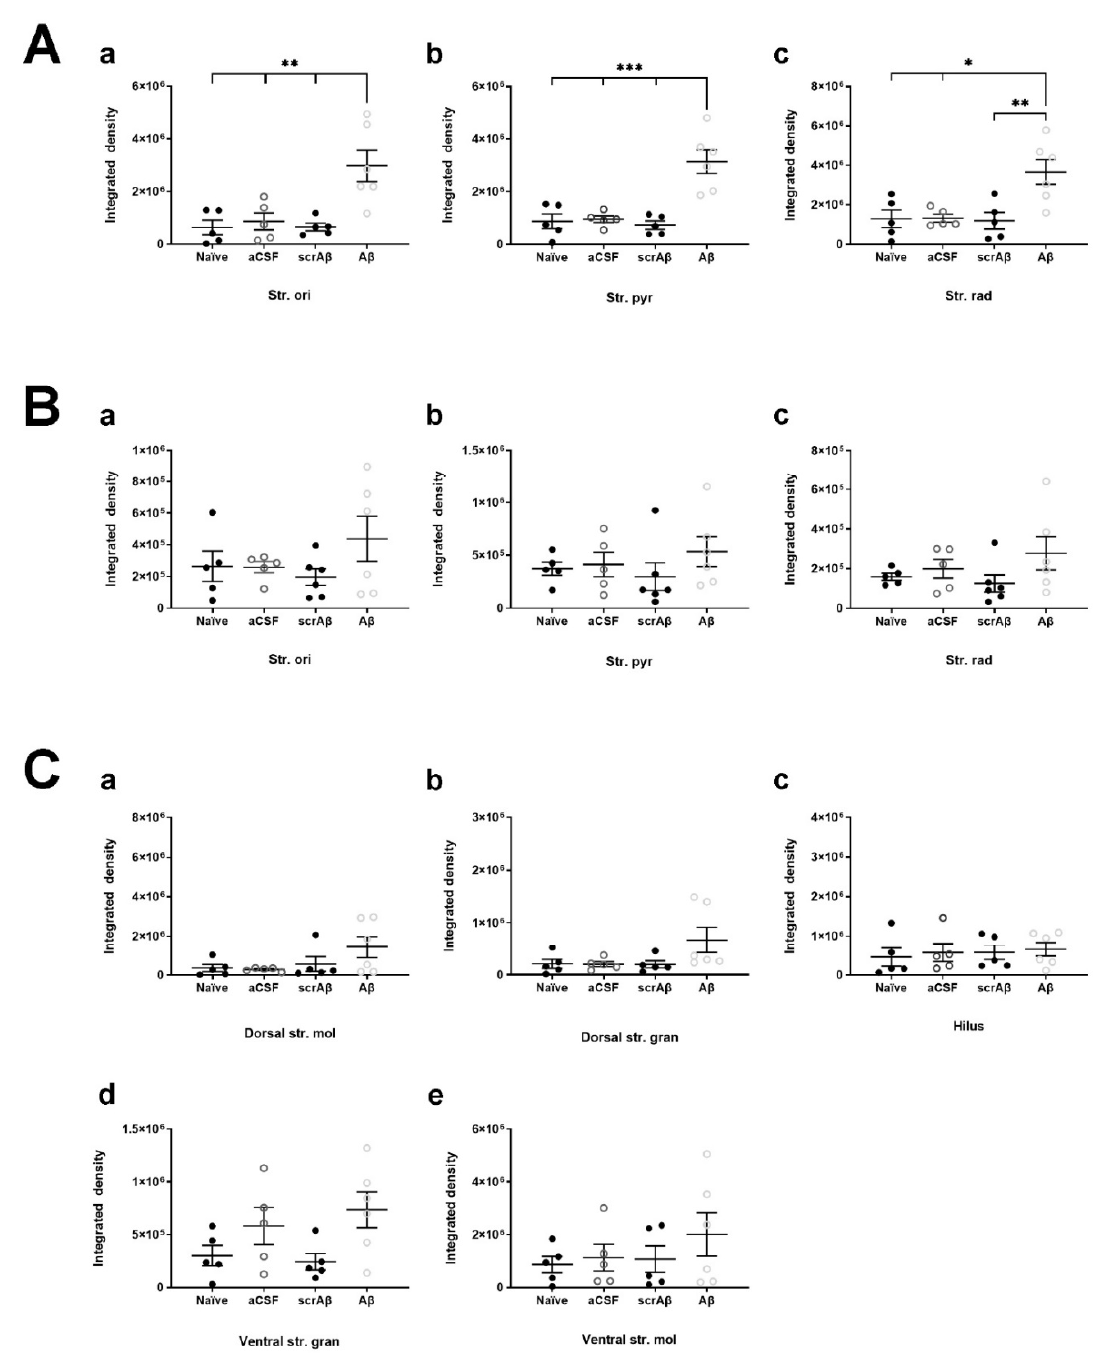
Figure 10. Quantification of NKCC1 density in the mouse hippocampus. ( A ) NKCC1 density in the str. oriens (str. ori), str. pyramidale (str. pyr) and str. radiatum (str. rad) of the ( A ) CA1 and ( B ) CA3 regions, and the dorsal and ventral str. moleculare (str. mol), hilus, and dorsal and ventral str. granulosum (str. gran) of the ( C ) DG. Data is expressed as the mean ± SEM. One-way ANOVA with Tukey’s multiple comparisons test, n = 4–6 for each experimental group (* p ≤ 0.05; ** p ≤ 0.01; *** p ≤ 0.001). Naïve = untreated mice; aCSF = ACSF-injected; A β = A β 1-42 -injected mice; scrA β = scrambled A β 1-42 -injected